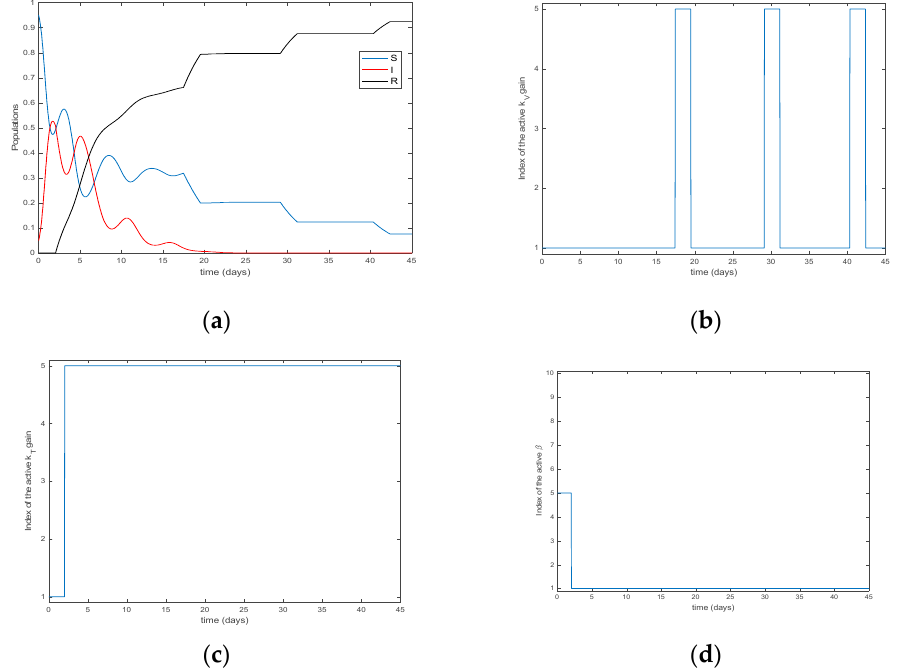
Figure 7. Performance of the system with seasonal incidence rate and vaccination and treatment actions tuned by Algorithm 2. ( a ) Evolution of model’s populations. ( b ) Index representing the active gain from S KV parameterizing the vaccination action. ( c ) Index representing the active gain from S KT parameterizing the treatment action. ( d ) Index representing the active model from S β parameterizing the transmission rate.